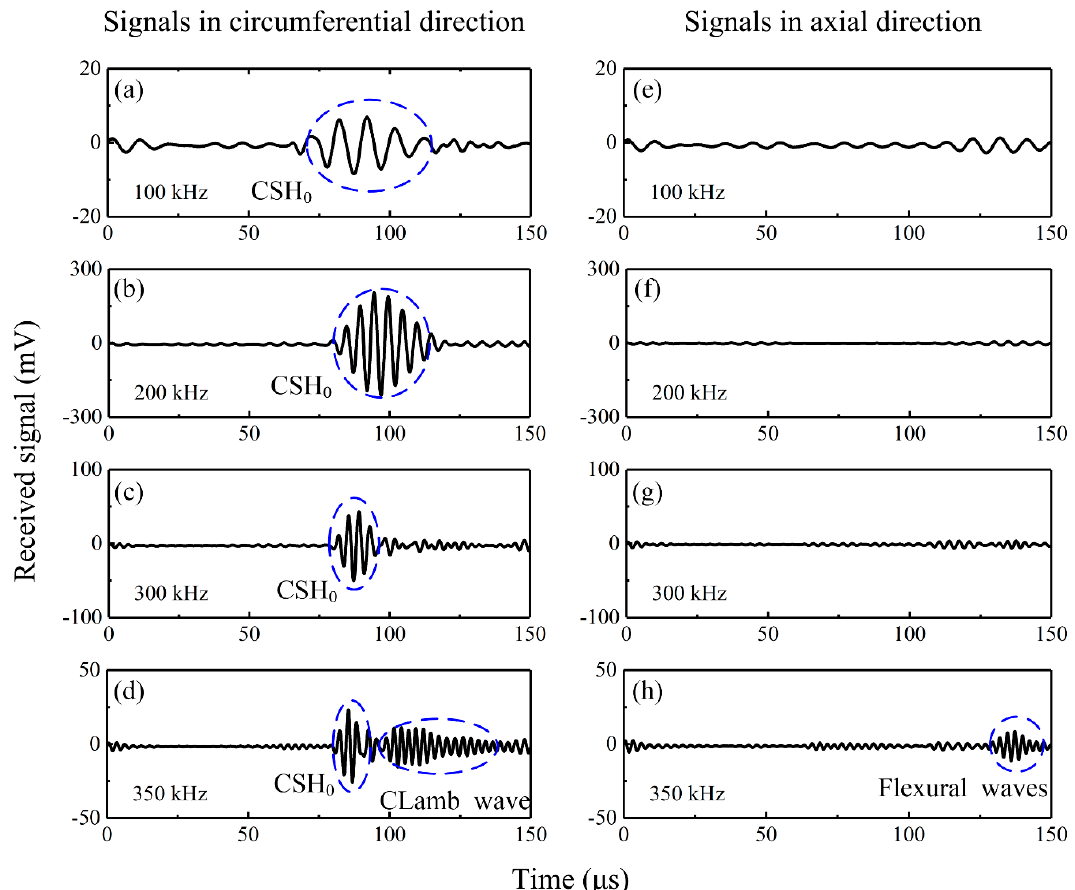
Figure 8. Wave signals excited by the bidirectional piezoelectric transducer at different frequencies and received by d 36 PMN-PT sensors. ( a – d ) wave signals propagating in the circumferential direction, ( e – h ) wave signals propagating in the axial direction of the pipe.